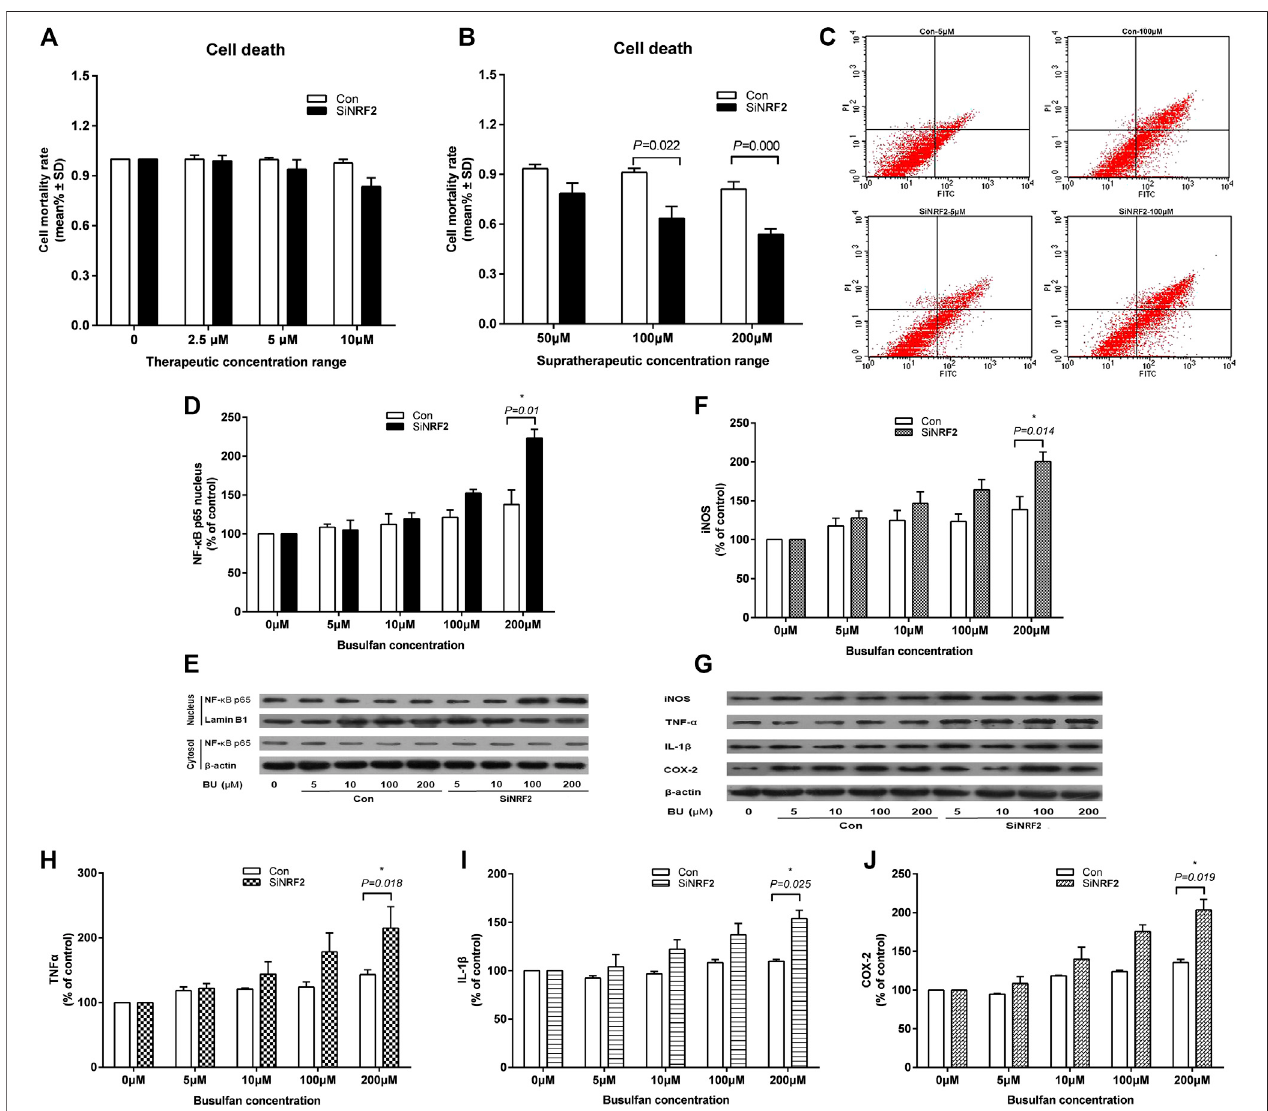
FIGURE 4 | High exposure of endothelial cell to BU induced a proin fl ammatory response mediated by NF- κ B and the toxicity in the absence of Nrf2. Death (A and B) and apoptosis (C) of human vascular endothelial cells (EA. hy 926) transfected with NRF2 speci fi c siRNA (siNRF2) or not (Control) exposed to therapeutic or supratherapeutic BU concentrations.WesternblotanalysisofNF- κ B (D and E) ,iNOS,TNF- α ,IL-1 β ,andCOX-2 (F and G,H,I,J) proteinslevelsinEA.hy926cellsexposedtoincreasingBUconcentrations.